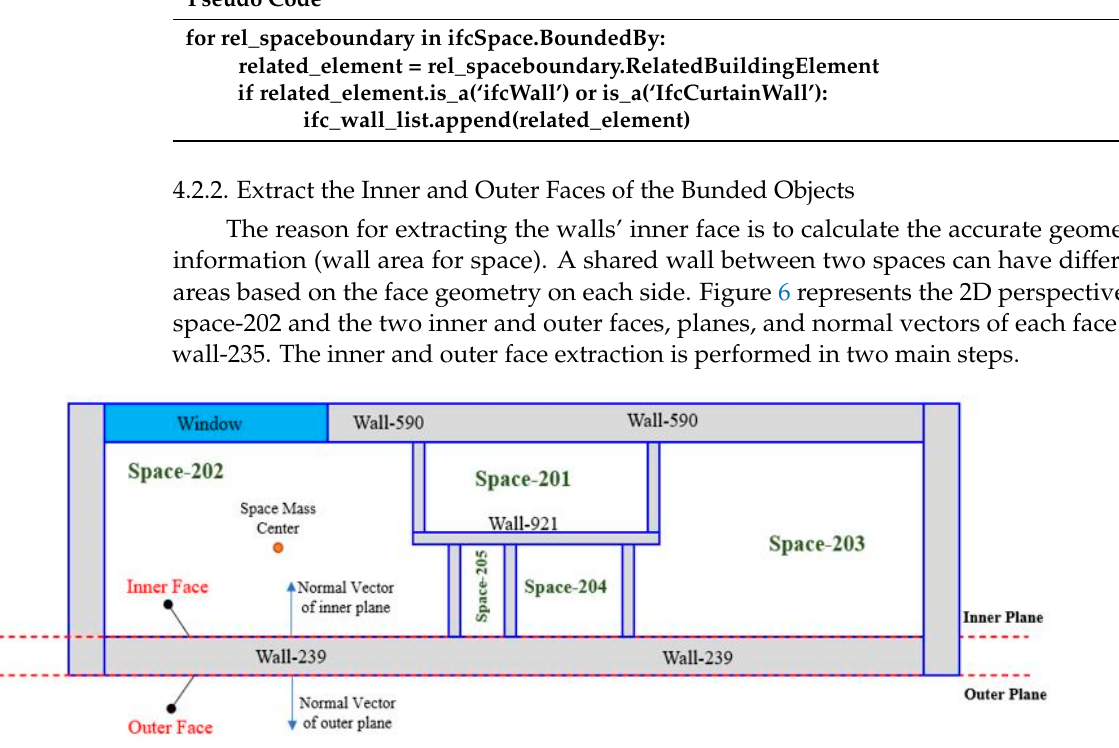
Figure 6. 2D perspective of space-202 and inner and outer of